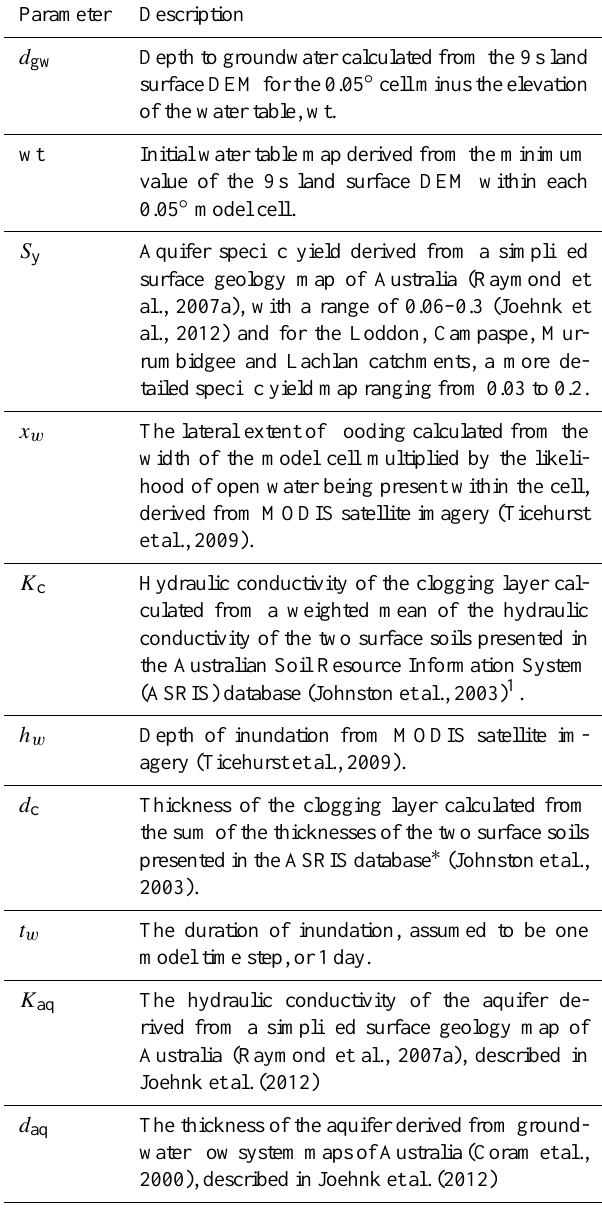
Table A1. Data used to populate the overbank flood recharge equations in